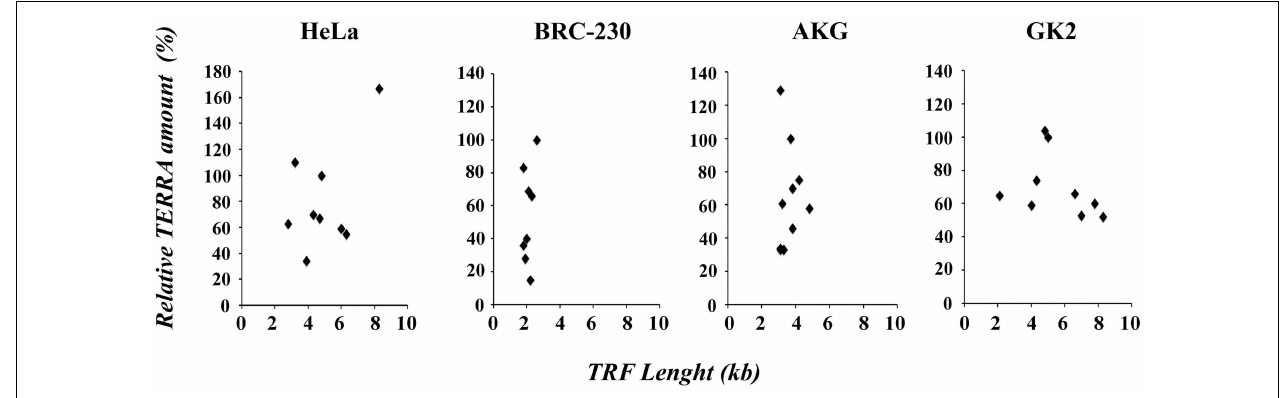
FIGURE 4 | Scatter plots ofTRF length versus relativeTERRA amount in HeLa, BRC-230,AKG, and GK2 parental cell lines and in their clones .